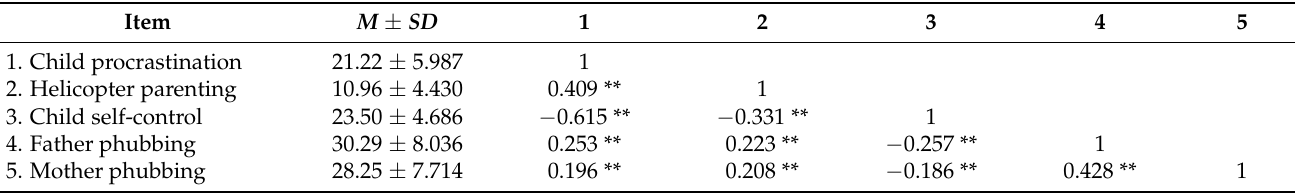
Table 3. Means, standard deviations, and correlations of the